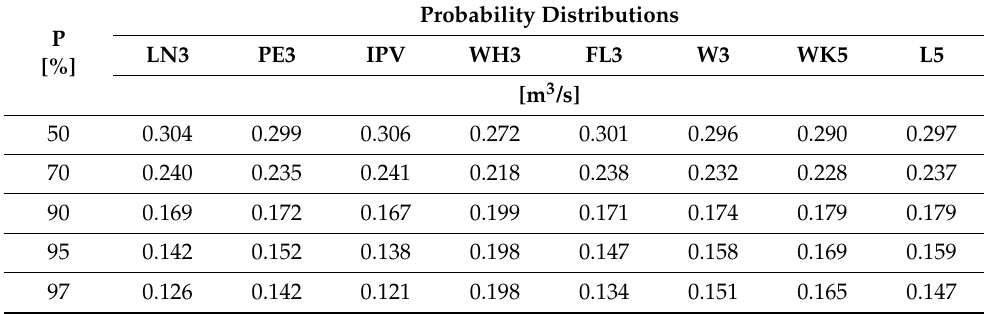
Table 7. Quantile results with MOM.